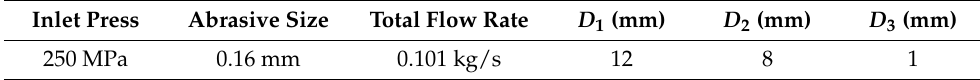
Table 5. Operating